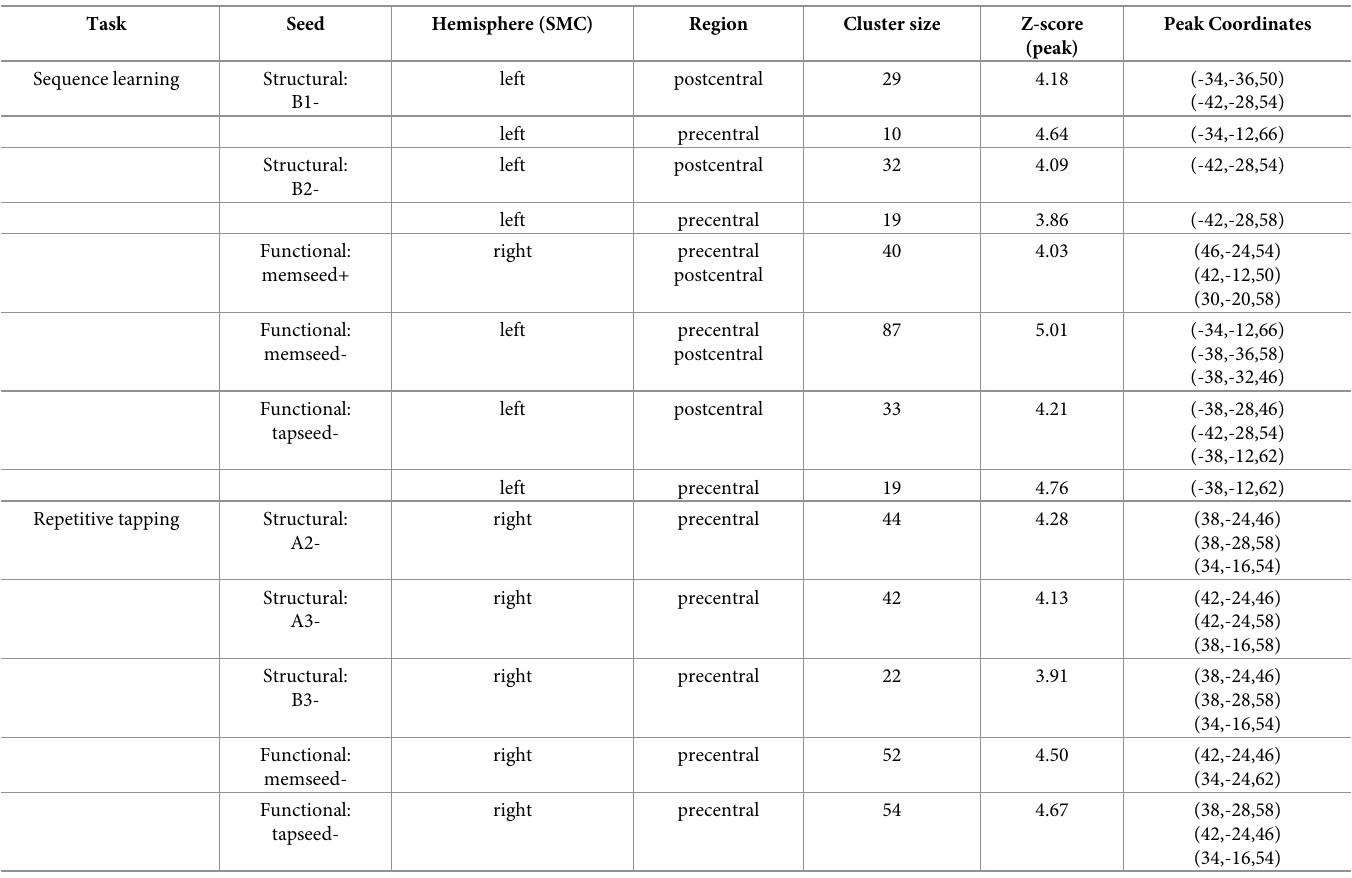
Table 4. Connectivity clusters within sensorimotor cortex during group analysis.